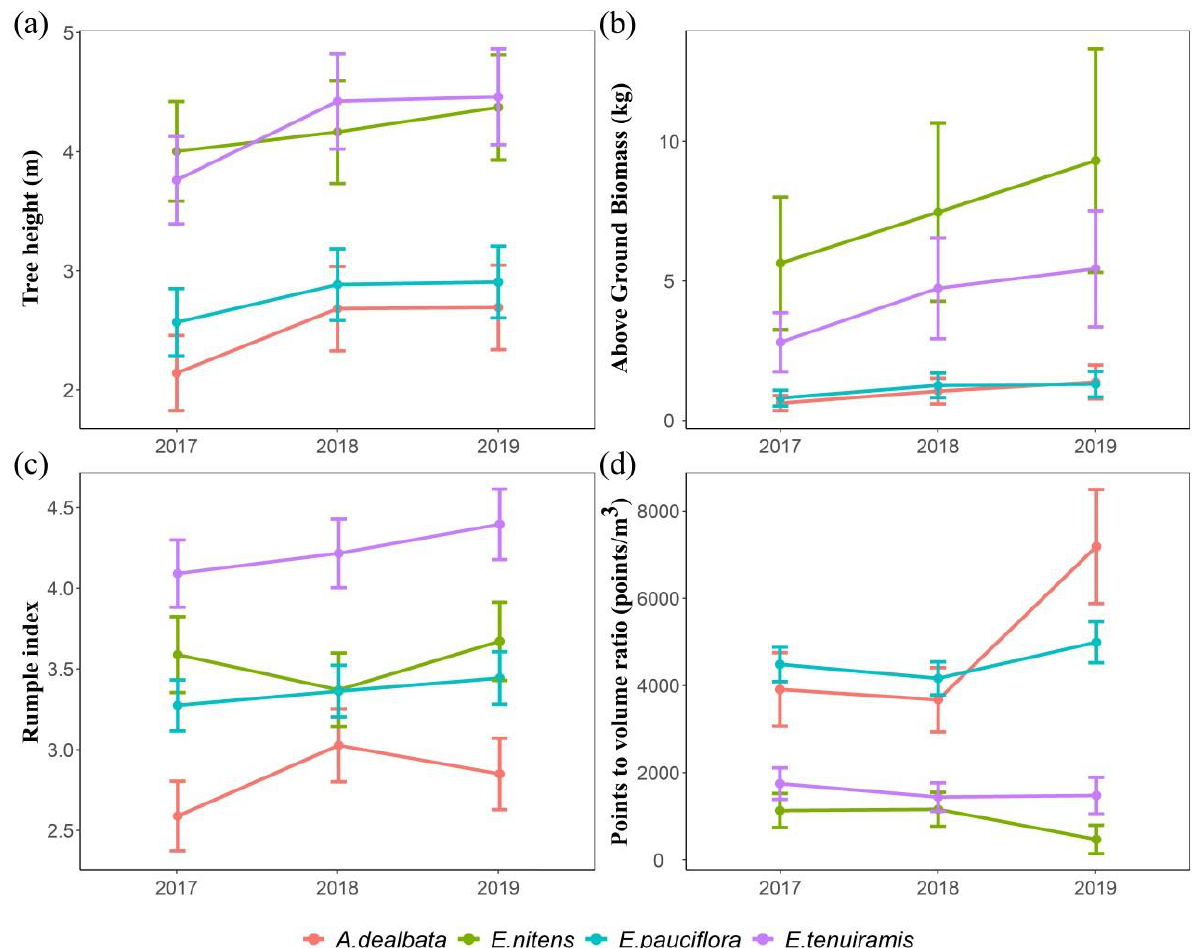
Figure 6. Species least-square mean plots across the three sampling years at the tree-levels estimated from the fitted model for tree height ( a ), above ground biomass ( b ), rumple index ( c ), and points to volume ratio ( d ).